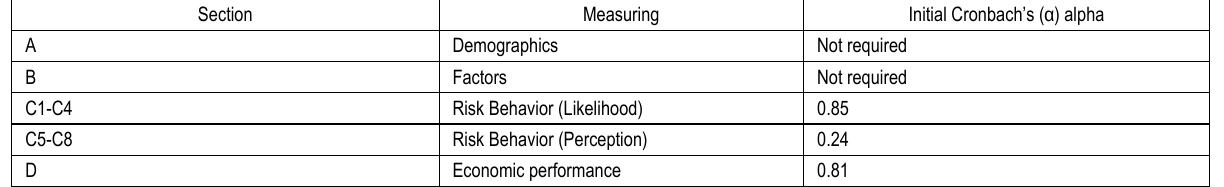
Table 3. Chi-square test for level of education